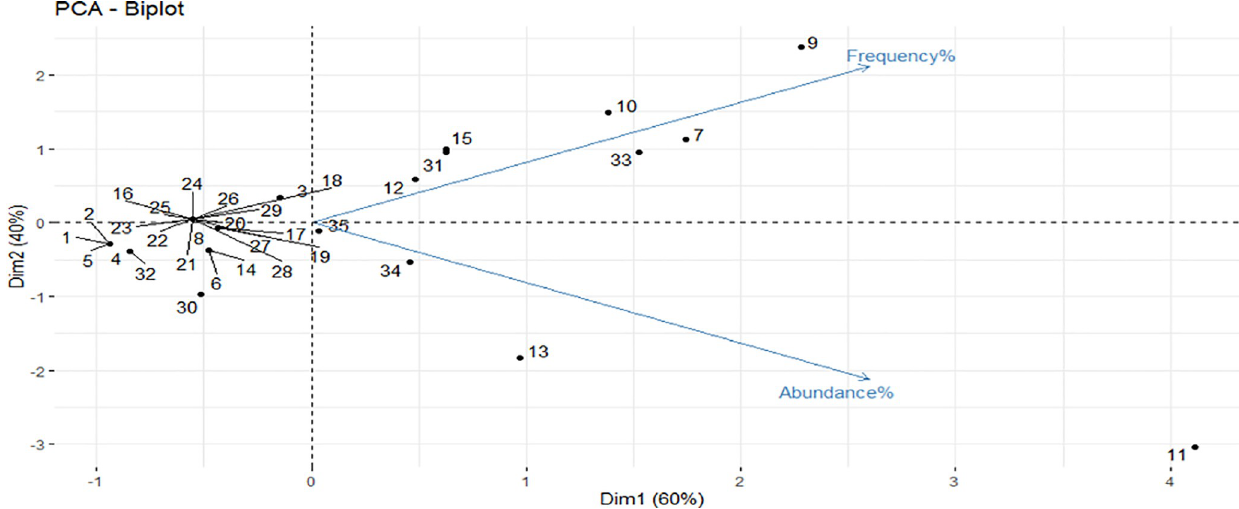
Fig 3. Biplot of abundance and frequency dimensions of individual unculturable bacteria in periapical abscesses.